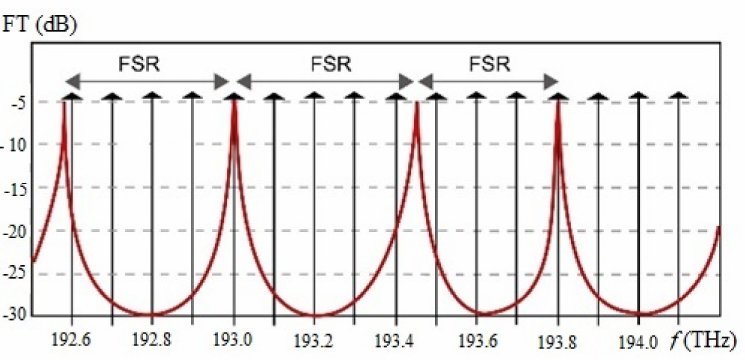
Figure 1. Periodic transmittance of an